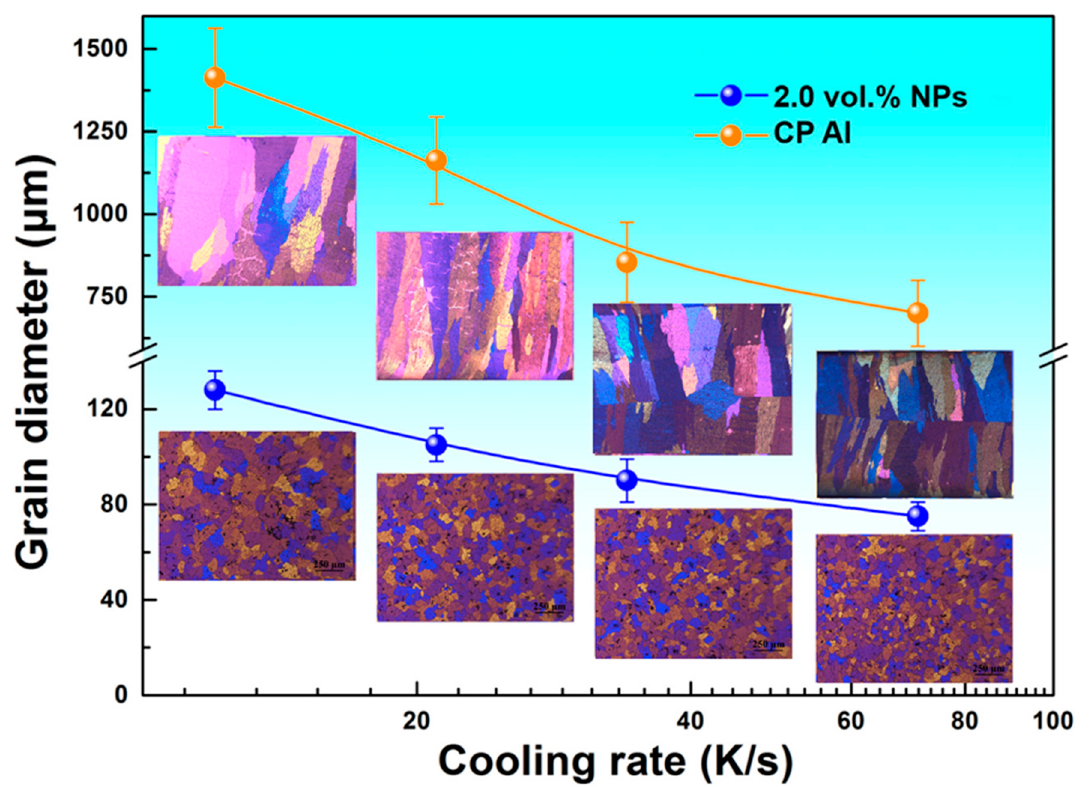
Figure 3. Variations in CP Al grain sizes with and without NP addition as functions of cooling rates. The insets are the anodized micrographs of the CP Al with and without NP addition solidified at different cooling conditions.